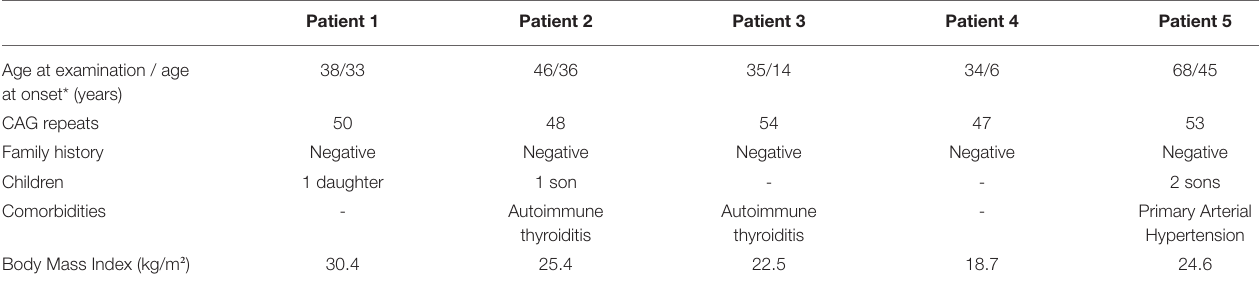
TABLE 1 | Patient characteristics.